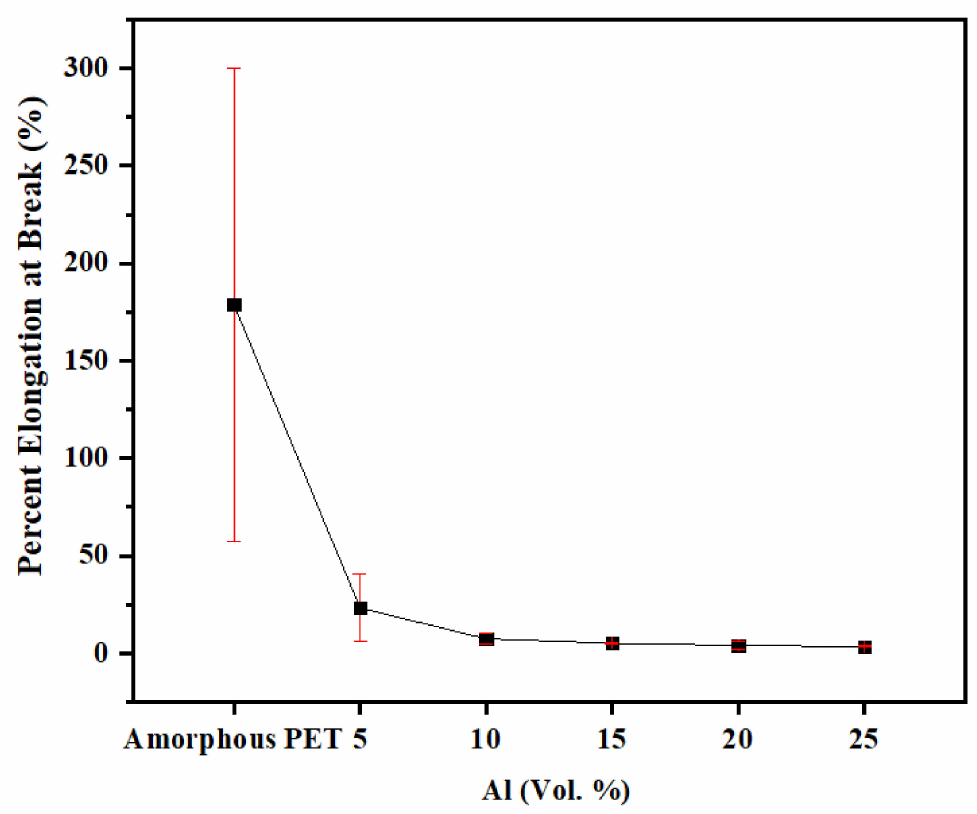
Figure 9. Elongation-to-break of amorphous PET filled with Al nano